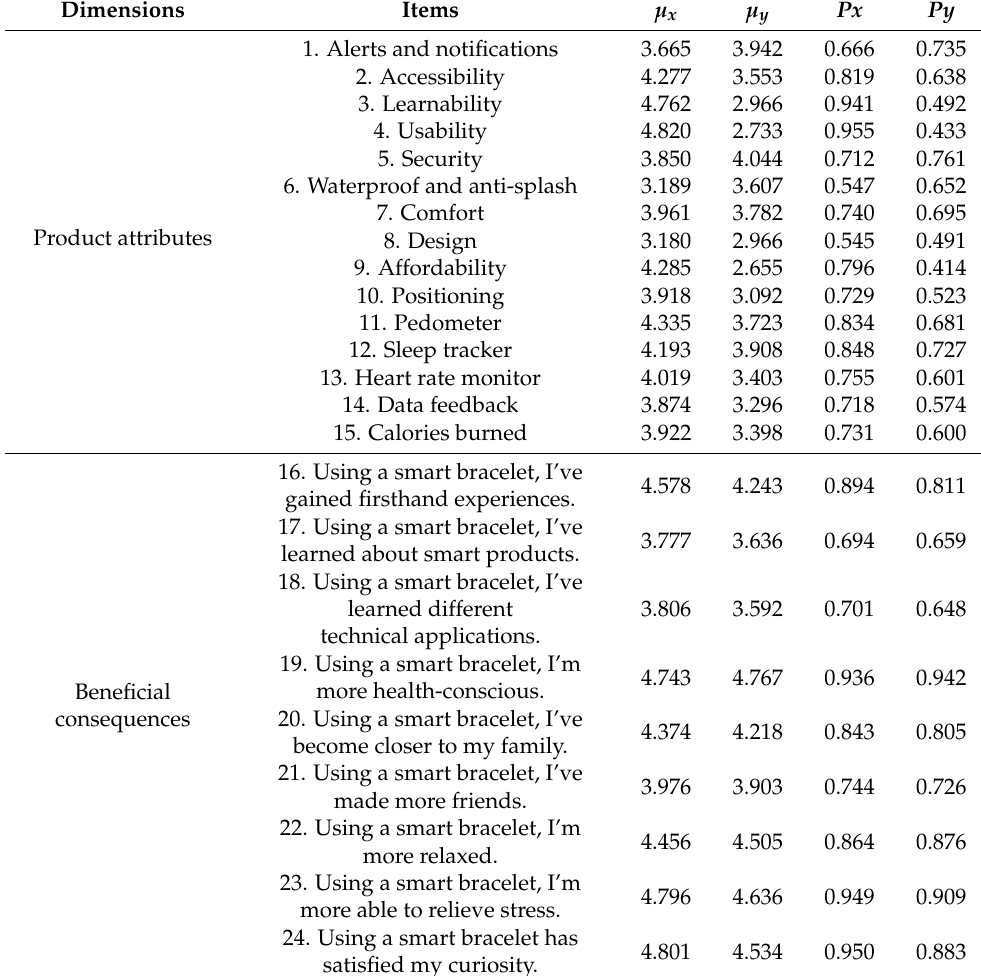
Table 3. Importance and Satisfaction Value of